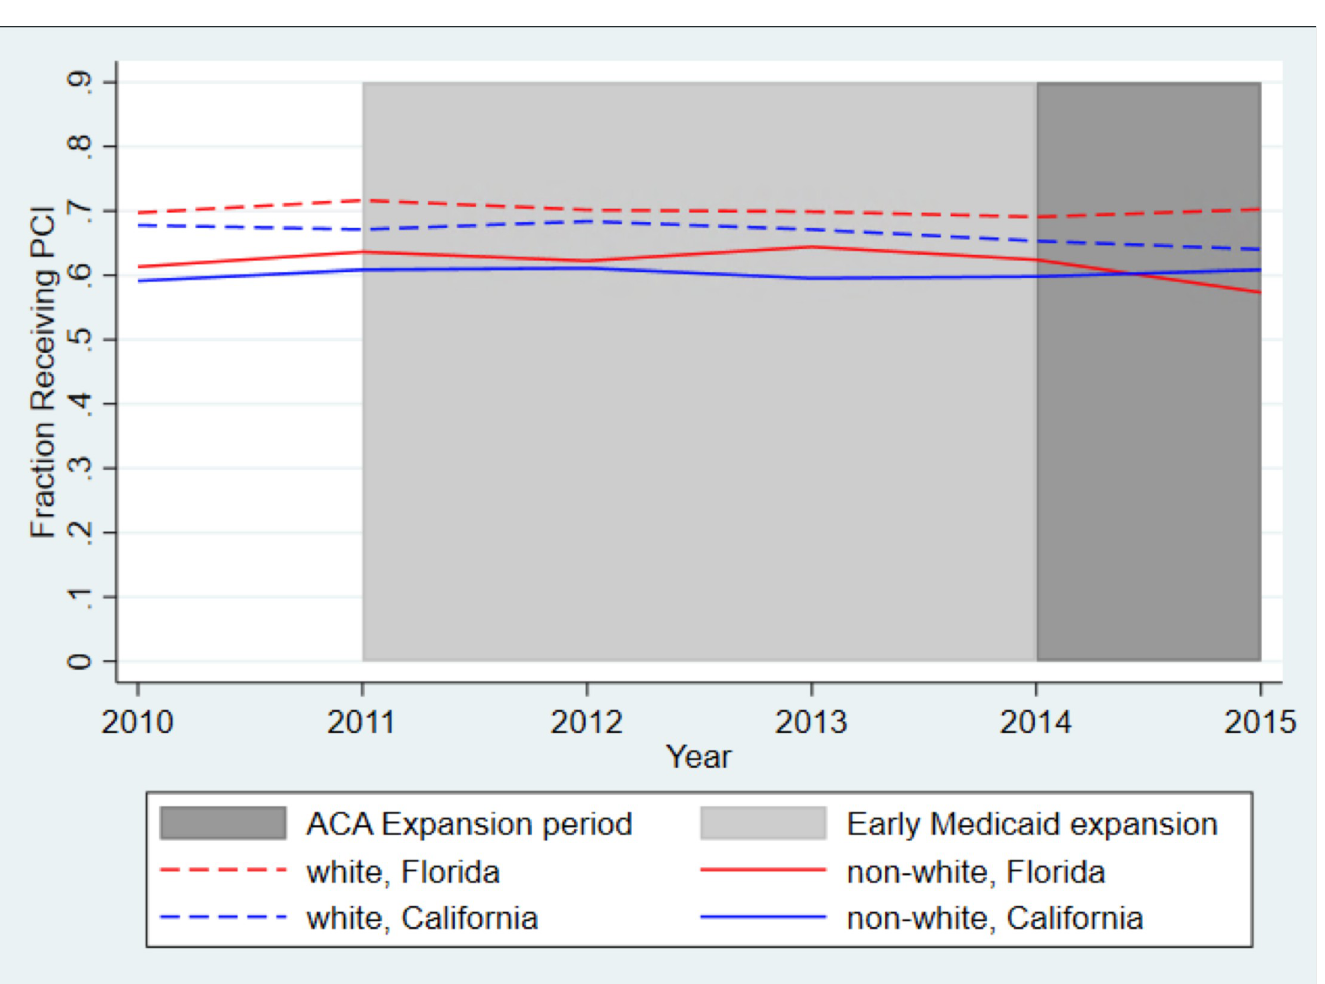
Fig 2. Unadjusted trends in likelihood of PCI in California and Florida, white patients and minority patients. Legend : The blue dashed line shows trends for white patients in California, the blue solid line shows trends for minority patients in California, the red dashed line shows trends for white patients in Florida, and the red solid line shows trends for minority patients in Florida. While all California counties expanded Medicaid by January 2014, as indicated by the dark grey area of the graph, some California counties began expanding Medicaid at earlier dates, beginning as early as 2011, as indicated by the light grey area of the